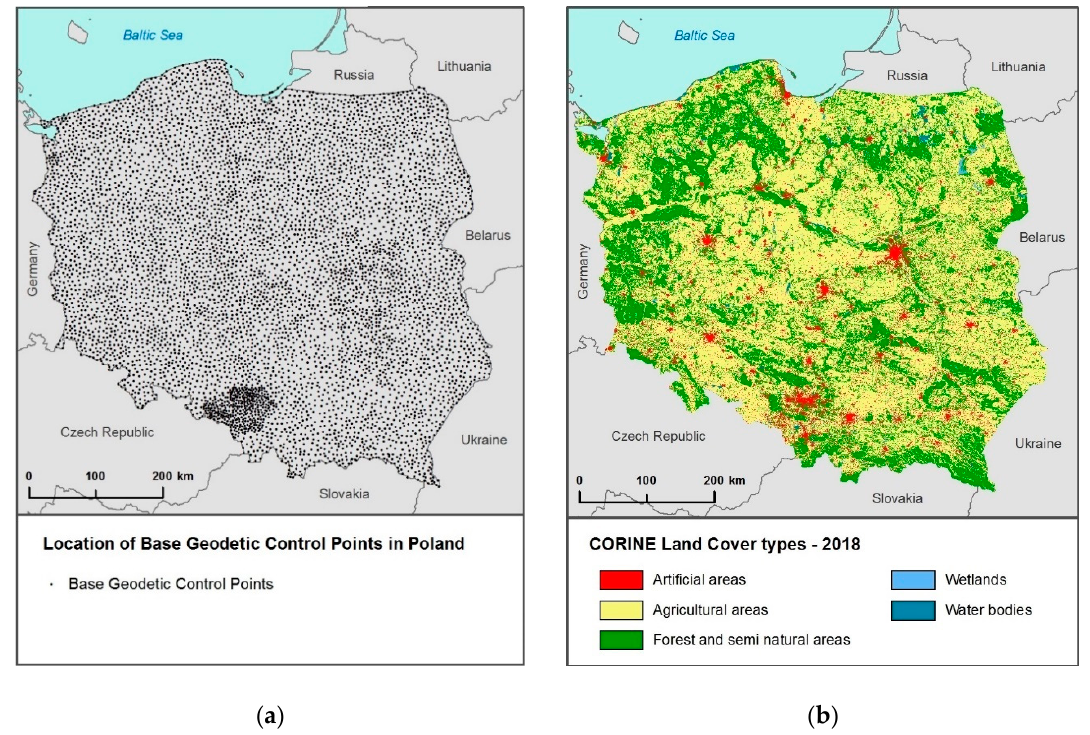
Figure 1. Poland: ( a ) Base geodetic control points (BGCPs) location; ( b ) CORINE Land Cover.